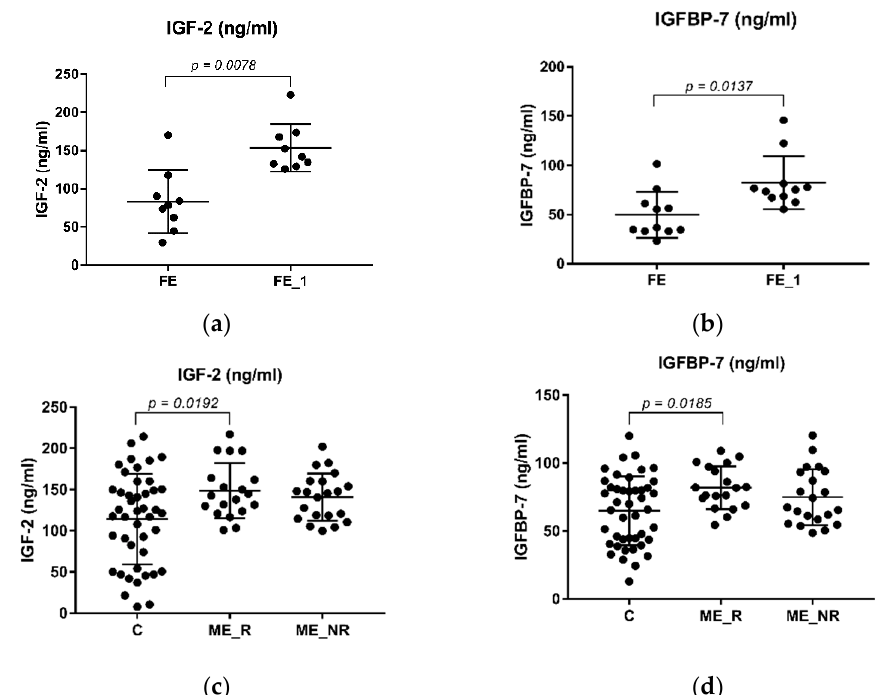
Figure 2. Plasma levels of IGF-2 (ng/mL) and IGFBP-7 (ng/mL) in SZ patients. ( a ) Levels of IGF-2 are significantly upregulated in related samples of FE_1. ( b ) Levels of IGFBP-7 are significantly upregulated in related samples of the FE_1 group. A Wilcoxon paired test was applied in both ( a , b ), and significant p -values are shown in each graph. No statistical difference was found in both ( c ) IGF-2 and ( d ) IGBFP-7 levels between ME_R and ME_NR. The levels of both IGF-2 ( c ) and IGFBP-7 ( d ) were found upregulated in the ME_R compared to the control group. An unpaired t-test was performed to calculate p -values. Significant p -values are given in each graph. FE: First Episode drug-naïve patients, FE_1: First Episode group after treatment, ME: multiple or chronic patients, ME_R: ME patients who had previously responded to treatment, ME_NR: ME patients who had not responded to treatment.